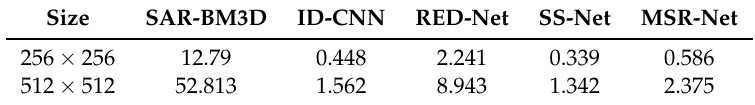
Table 8. Runtime (s) of different methods of images with sizes of 256 × 256 and 512 ×